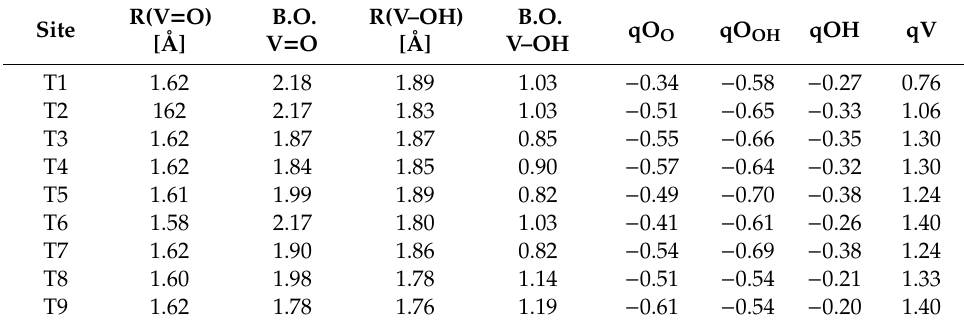
Table 4. Structural parameters of the V(=O)(–OH) group introduced to different crystallographic positions in BEA zeolite. O O denotes vanadyl oxygen, O OH denotes oxygen from hydroxyl. Site